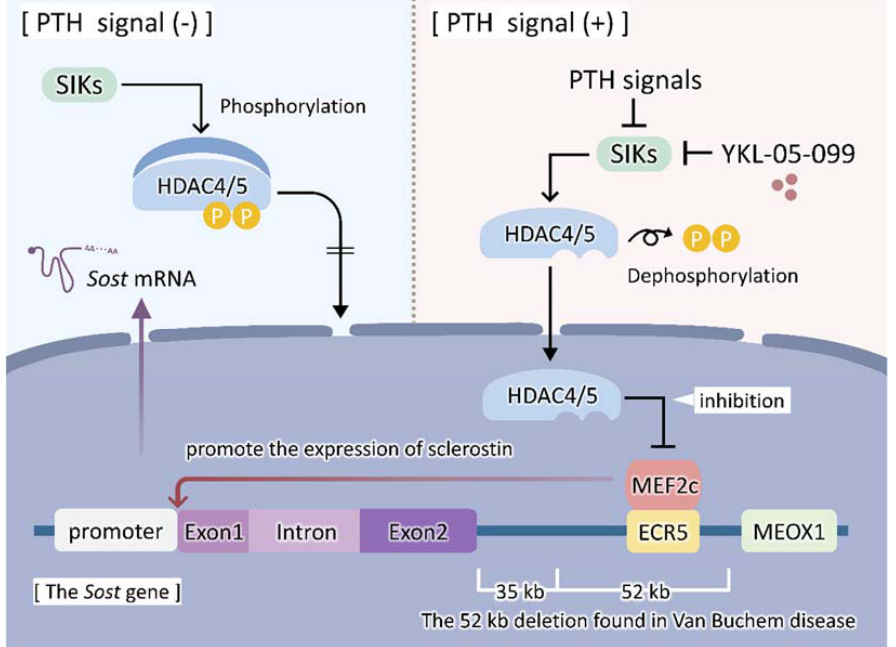
Figure 1. Structure of the Sost gene and effects of PTH on the expression of sclerostin. PTH signals suppress the expression of sclerostin. In the absence of PTH signals, salt ‐ inducible kinase (SIK) 2 phosphorylates HDAC4/5 to promote the cytoplasmic retention of HDAC4/5. MEF2c binds to ECR5 (enhancer region) of the Sost gene to promote the expression of sclerostin. PTH signals inhibit the phosphorylation of HDAC4/5 by SIK2. Dephosphorylated HDAC4/5 remain in the nucleus and inhibit the transcriptional activity of MEF2c. YKL ‐ 05 ‐ 099, a small ‐ molecule SIK inhibitor, mimics the effects of PTH. PTH, parathyroid hormone; SIK, salt ‐ inducible kinase; HDAC, histone deacetylase; MEF, myocyte enhancer factor; ECR, evolutionarily conserved region; MEOX1, mesenchyme homeobox 1.